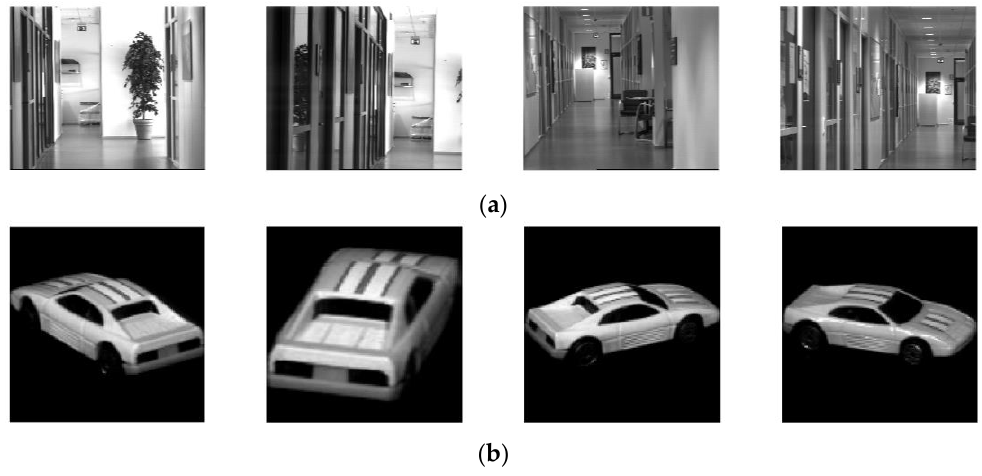
Figure 3. Image examples from two databases. ( a ) shows images taken by a Teli CS8620HCi and ( b ) shows images taken by a SONY XC-77.